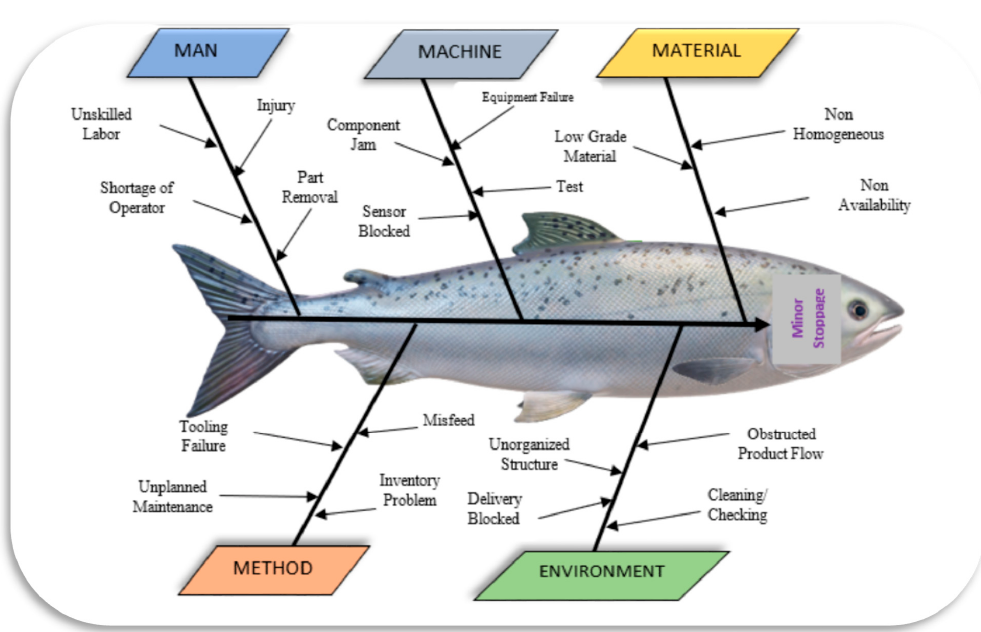
Figure 7. Fishbone diagram for a minor stoppage.